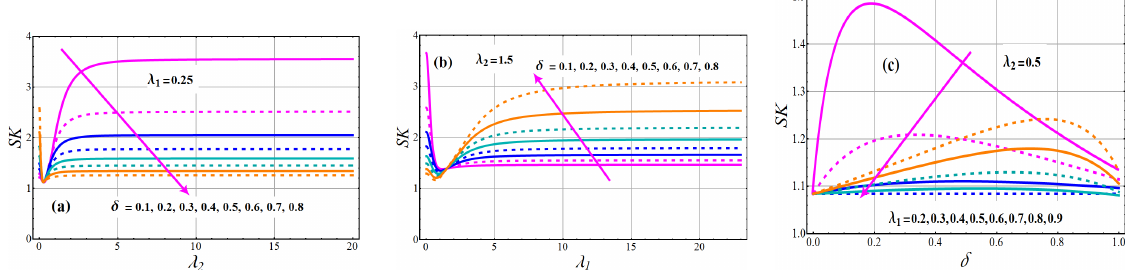
Fig. 5. Variations of Index of dispersion of TC-MAM ( $ ) .